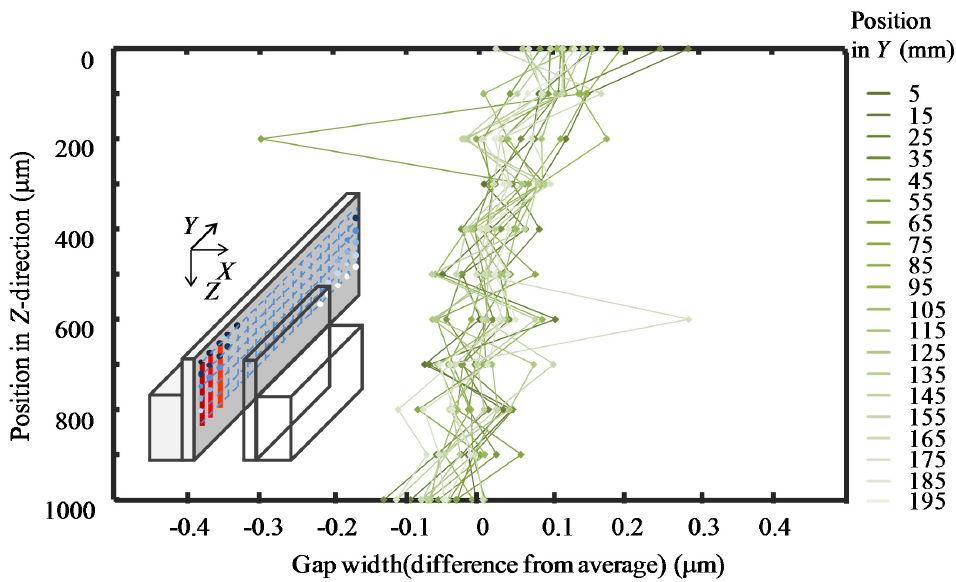
Figure 19. Gap width uniformity over the entire slot die length ( Z ‐ direction).